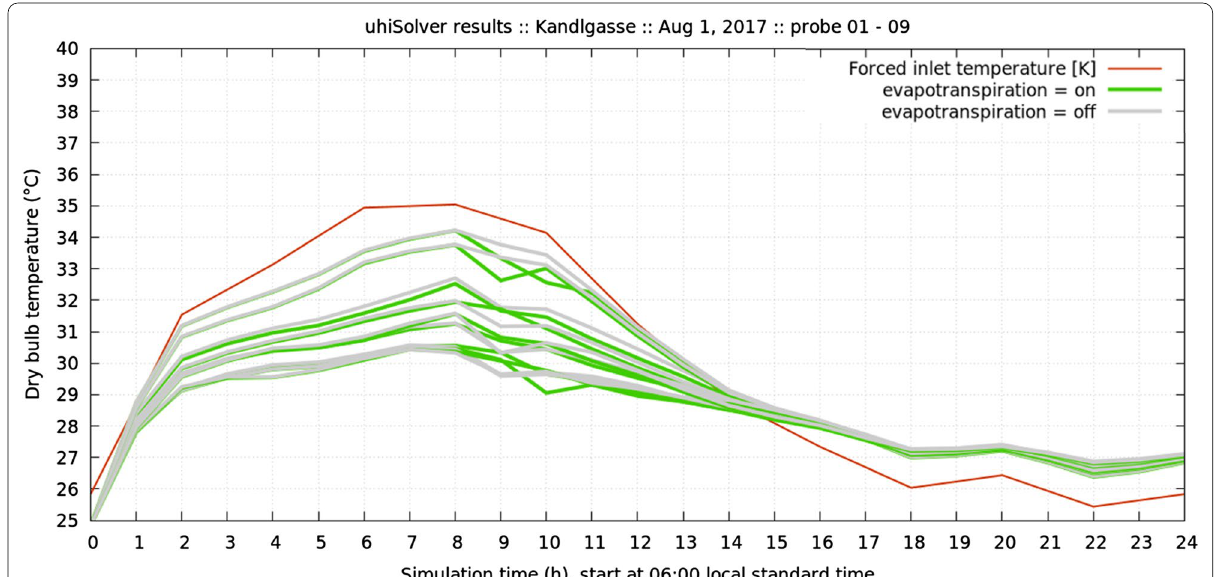
Fig. 11 Overview of the temperature profiles of probes 01–09 with (green lines) and without evapotranspiration (grey lines) compared to the forced inlet temperature (red